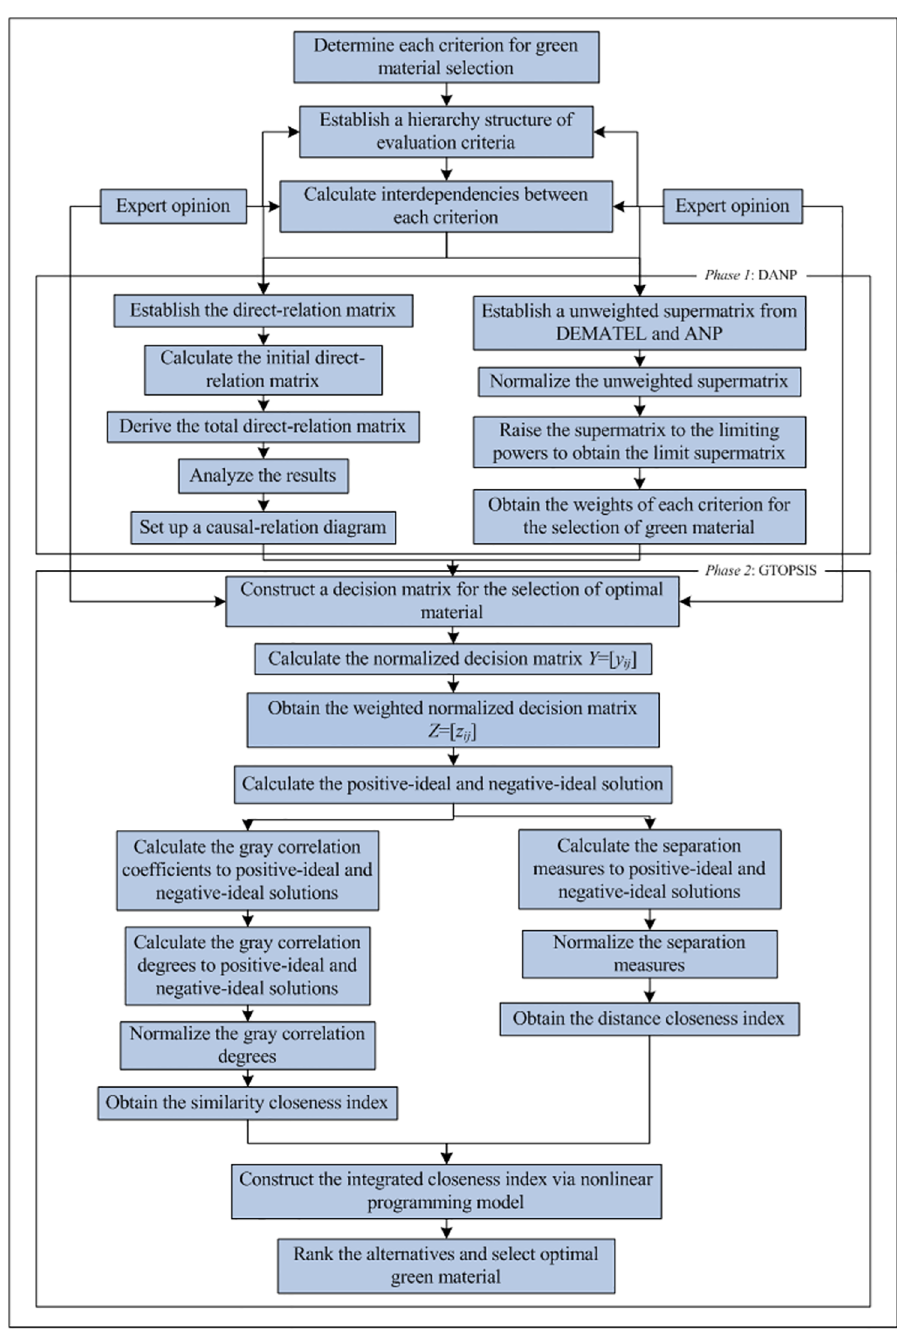
Fig 1. The flowchart of proposed novel hybrid